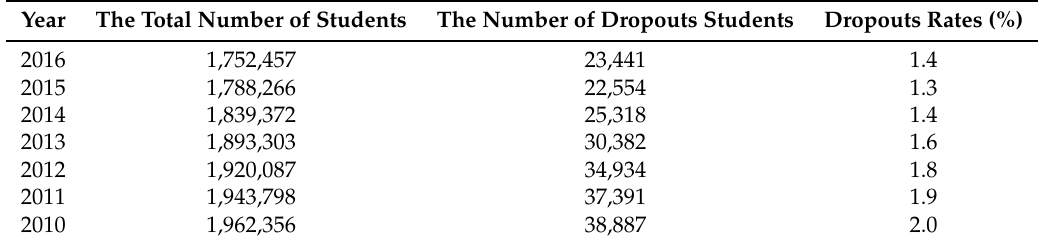
Table 1. The Dropout rates of high school students in South Korea from 2010 to